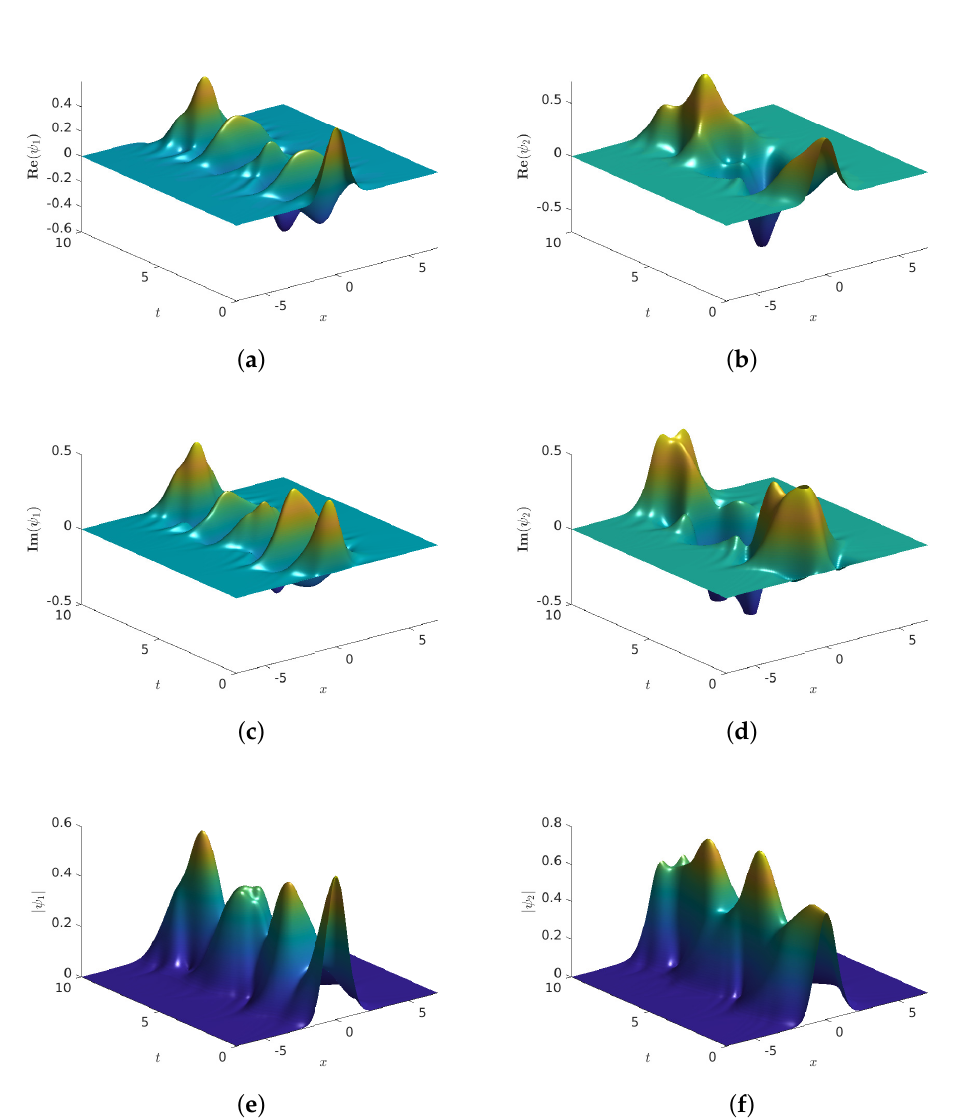
Figure 2. Numerical approximations to the solutions of Equation (4) versus x and t , using the constants of Table 1. The graphs were obtained using the finite-difference method of Equation (16) with T = 10, α 1 = α 2 = 1.5, τ = 0.01 and h − 1 = 0.1. We also let V ( x ) = 1 1 √ exp ( − x 2 ) , for each x ∈ Ω . The graphs provide ( a ) Re ( Ψ 1 ) , ( b ) Re ( Ψ 2 ) , ( c ) Im ( Ψ 1 ) , ( d ) Im ( Ψ 2 ) , π ( e ) | Ψ 1 | , and ( f ) | Ψ 2 |